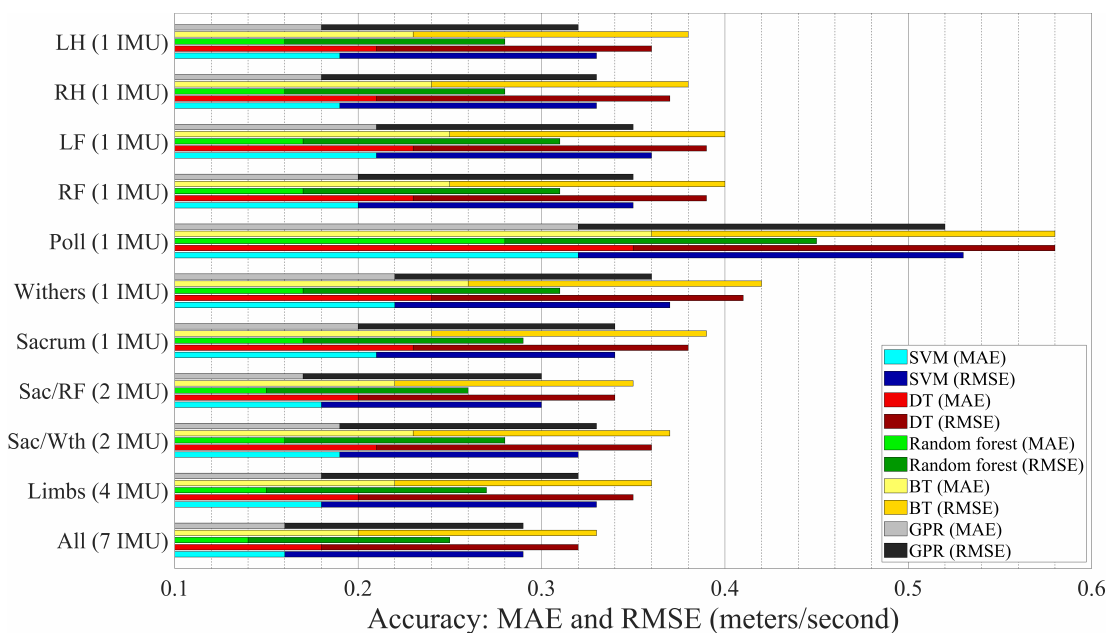
Figure 3. Comparison of models performances using MAE (m/s) and RMSE (m/s).